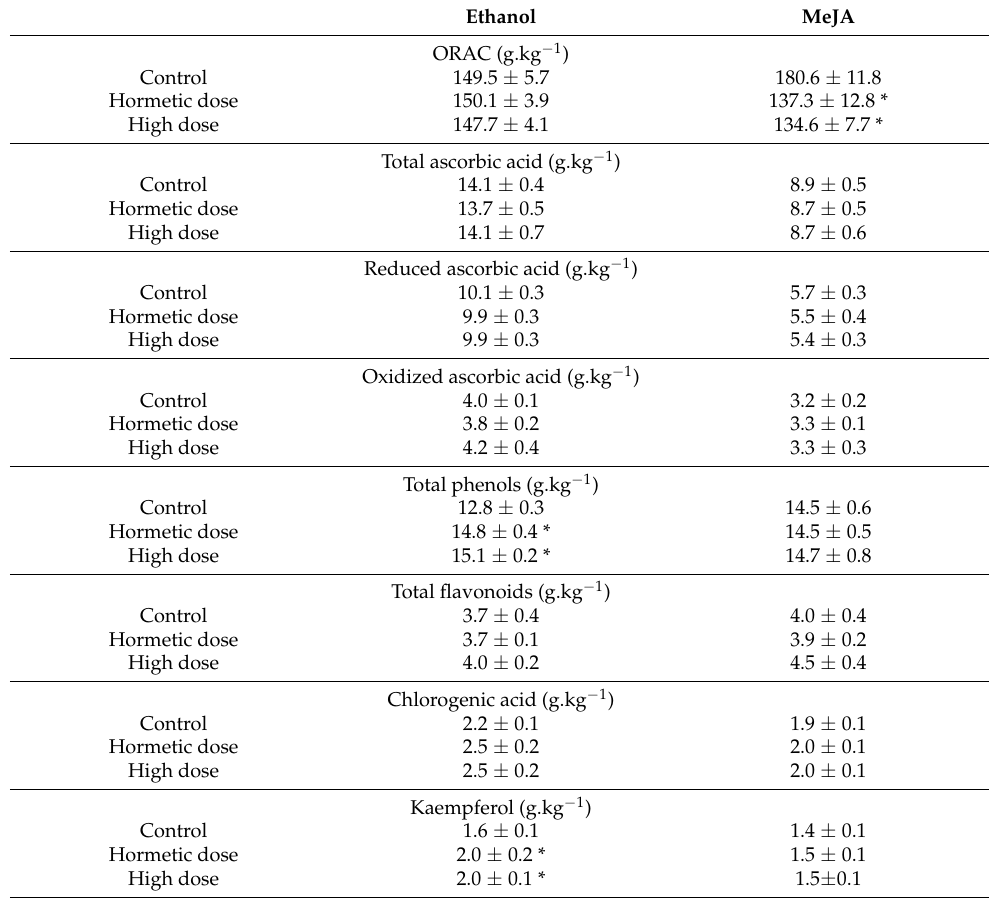
Table 3. Oxygen radical absorbance capacity (ORAC, Trolox equivalents), ascorbic acid (oxidized, reduced, or total), total phenols (gallic acid equivalents), total flavonoids (quercetin equivalents), chlorogenic acid, and kaempferol (sinigrin equivalents) contents in broccoli florets exposed to ethanol and methyl jasmonate. Florets were exposed to three different doses of ethanol (control: 0 µ L.L − 1 ; hormetic: 10,000 µ L.L − 1 /30 min; high: 10,000 µ L.L − 1 /120 min) and methyl jasmonate (control: 0 µ L.L − 1 ; hormetic: 1 µ L.L − 1 /45 min; high: 1 µ L.L − 1 /180 min), stored for 14 days in darkness at 4 ◦ C, and